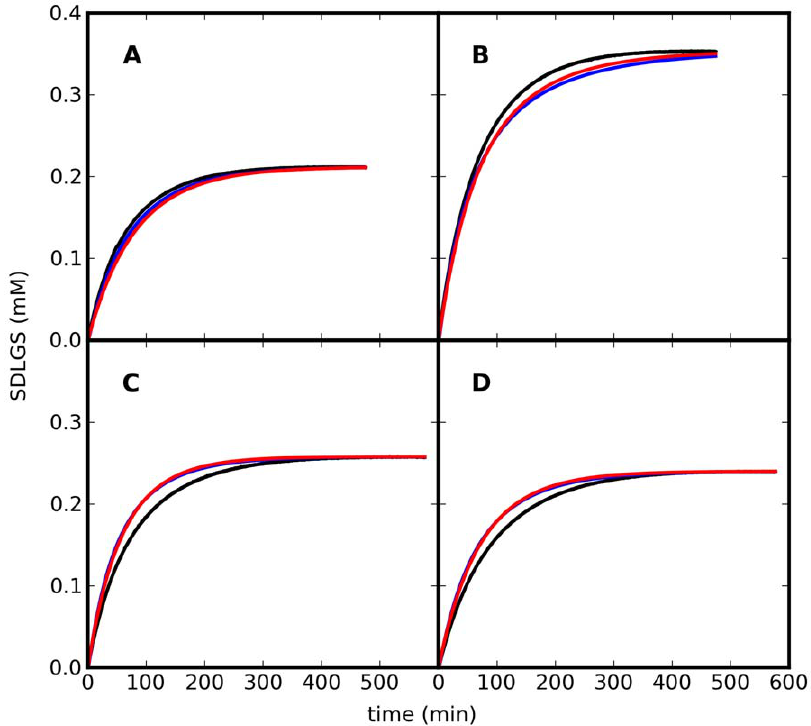
Figure 3. Time courses of SDLGS formation in the reaction of yeast glyoxalase I. Black: experimental data. Blue: time course predicted by model 1. Red: time course predicted by model 2. Experimental time courses and initial concentrations are included in dataset S1.